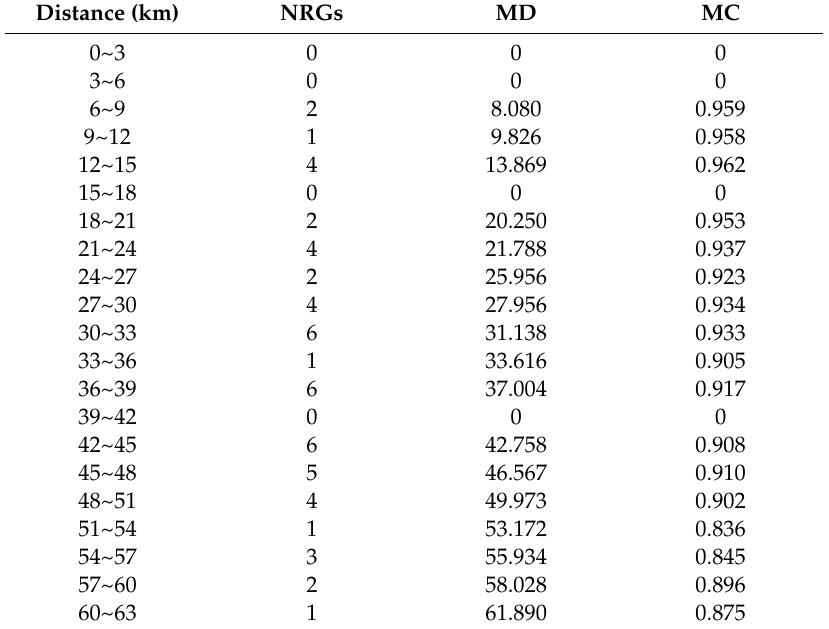
Table 2. Statistical result of the number of rain gauges (NRGs), the mean distance (MD), and mean correlation (MC) at the rain